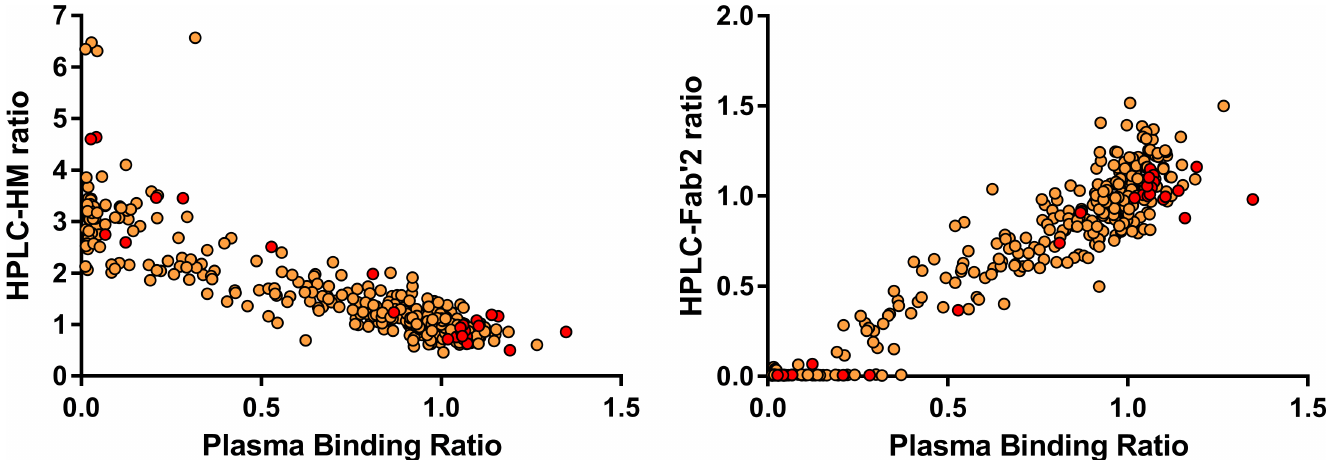
Fig 1. Correlation between radio-HPLC and plasma binding assay. Strong correlation was observed betweenplasma bindingassay and HPLC assay. Samples were assayed with either F(ab 0 ) 2 -CD4R1antibody(brown dots) or F(ab 0 ) 2 -huOKT4A antibody(red dots). For samples assayed with F(ab 0 ) 2 - CD4R1, the bootstrap estimate and 95% confidenceinterval of the Spearman rank correlationbetweenPBA-ratio and HPLC-HM-ratio was -0.88 (-0.91, -0.84), and betweenPBA-ratio and HPLC-Fab’2-ratio was 0.90 (0.85, 0.93). Similar results were observedfor samples assayed with F(ab 0 ) 2 -huOKT4A.